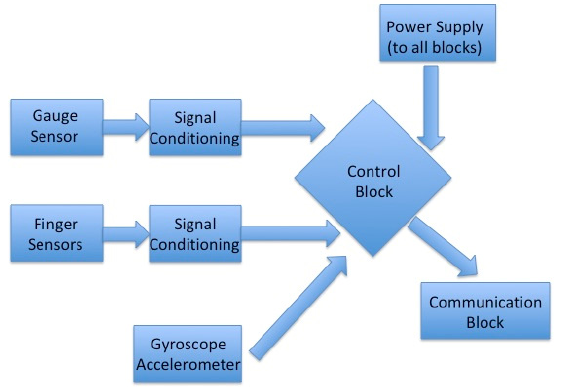
Figure 2. Hardware components of the device.